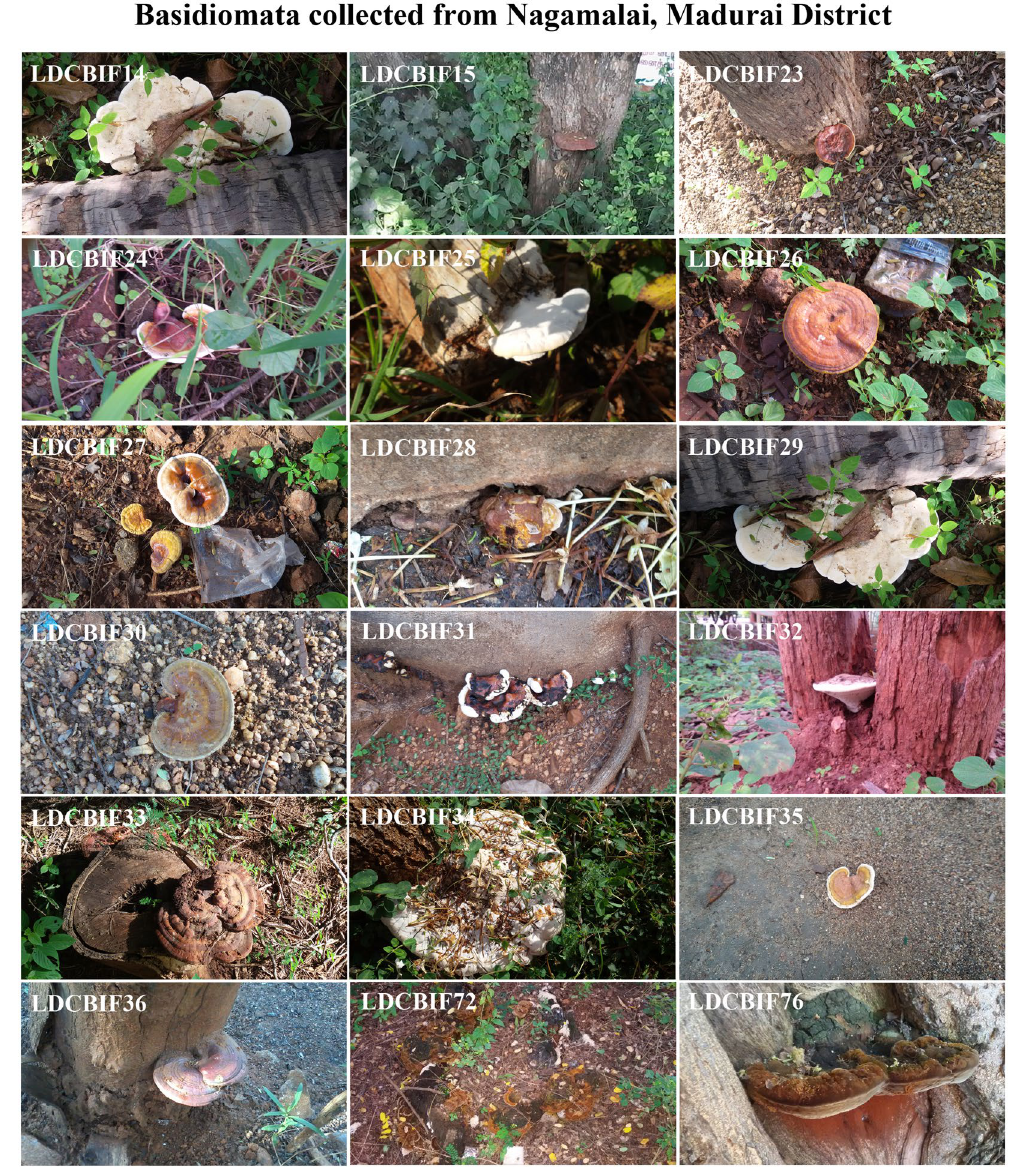
Figure 2. Field photographs of Basidiomata collected from Nagamalai, Madurai District. The macrofungi grown on the host species: Albizzia sp., - LDCBIF32, LDCBIF33, LDCBIF35, LDCBIF72, LDCBIF76; Azadirachta sp., - LDCBIF30; Cocos sp., - LDCBIF24 and Tamarindus sp., - LDCBIF15, LDCBIF36. Few isolates were collected from the decayed matter (LDCBIF23, LDCBIF25, LDCBIF26, LDCBIF28, LDCBIF29, LDCBIF31) and wood log (LDCBIF14, LDCBIF27,